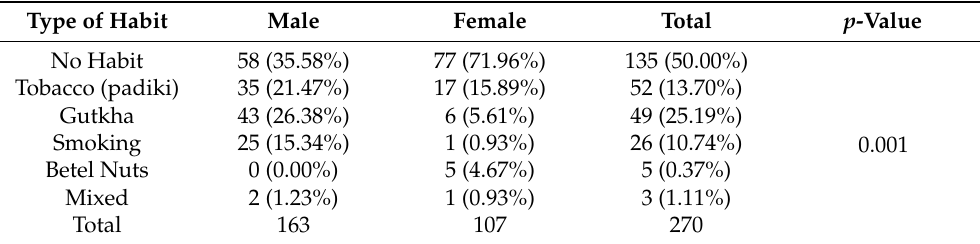
Table 2. Distribution of gender and tobacco